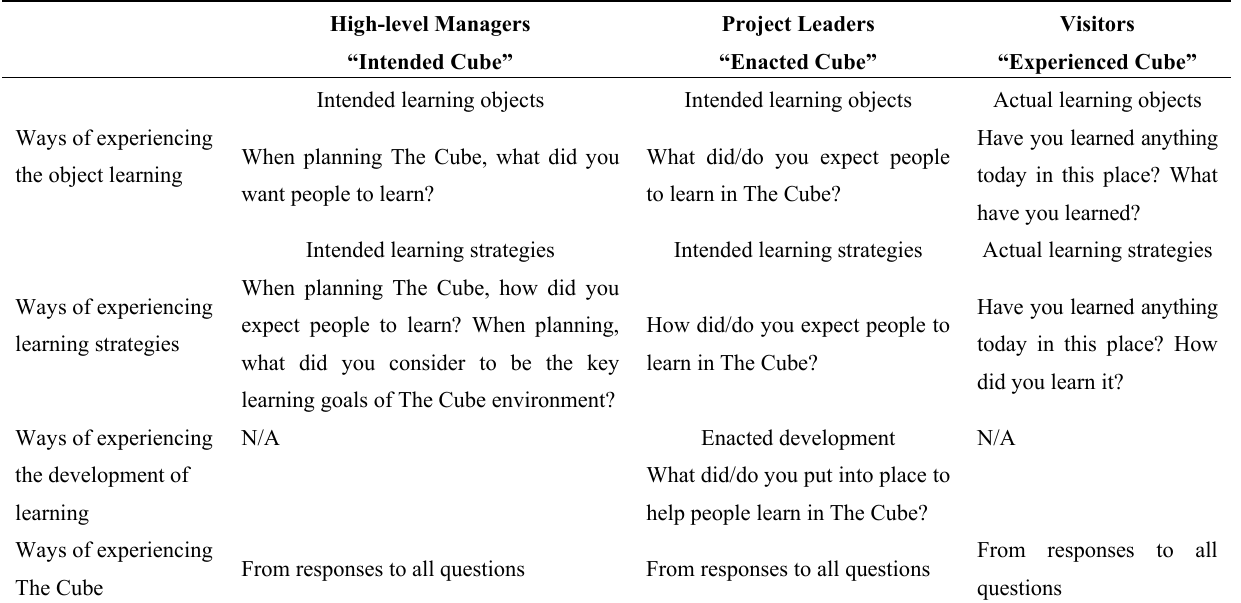
Table 2. The experience of learning in The Cube: Relating the conceptual tools of analysis to the interview